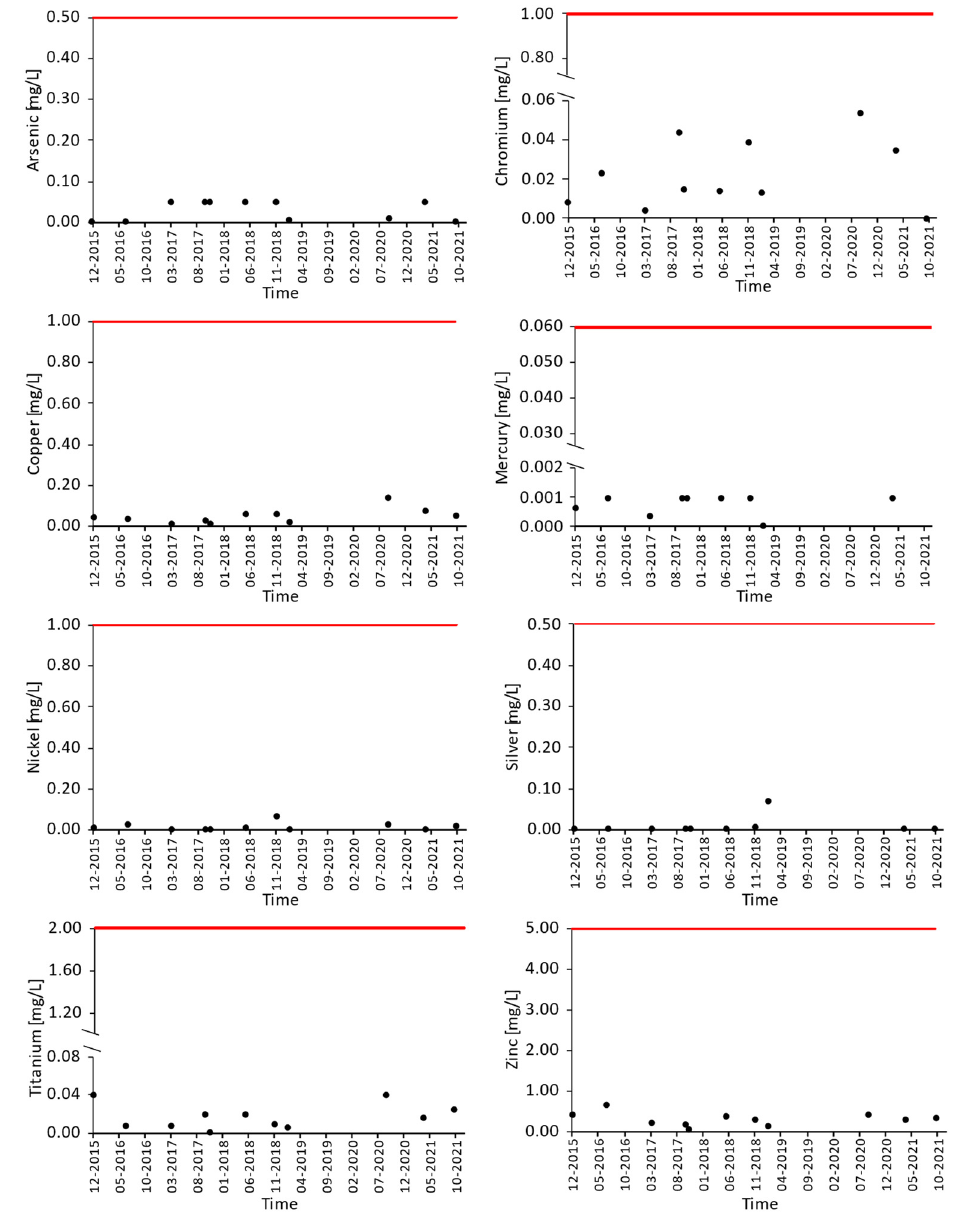
Figure 5. The heavy metal content in the industrial wastewater generated on the ZUOK site in Olsztyn between December 2015 and December 2021. The red line indicates the permissible values as set out in the integrated permit.